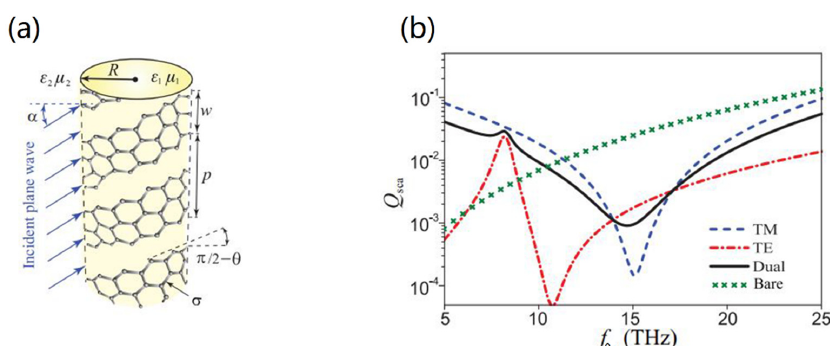
Figure 13. ( a ) Dielectric cylinder coated by helical graphene strips for oblique wave incidence. ( b ) Scattering efficiency versus wave frequency for a GCNW under normal incidence of TE, transverse-magnetic (TM), and dual-polarized waves. Reprinted with permission from reference [129]. Copyright American Physical Society, 2019.